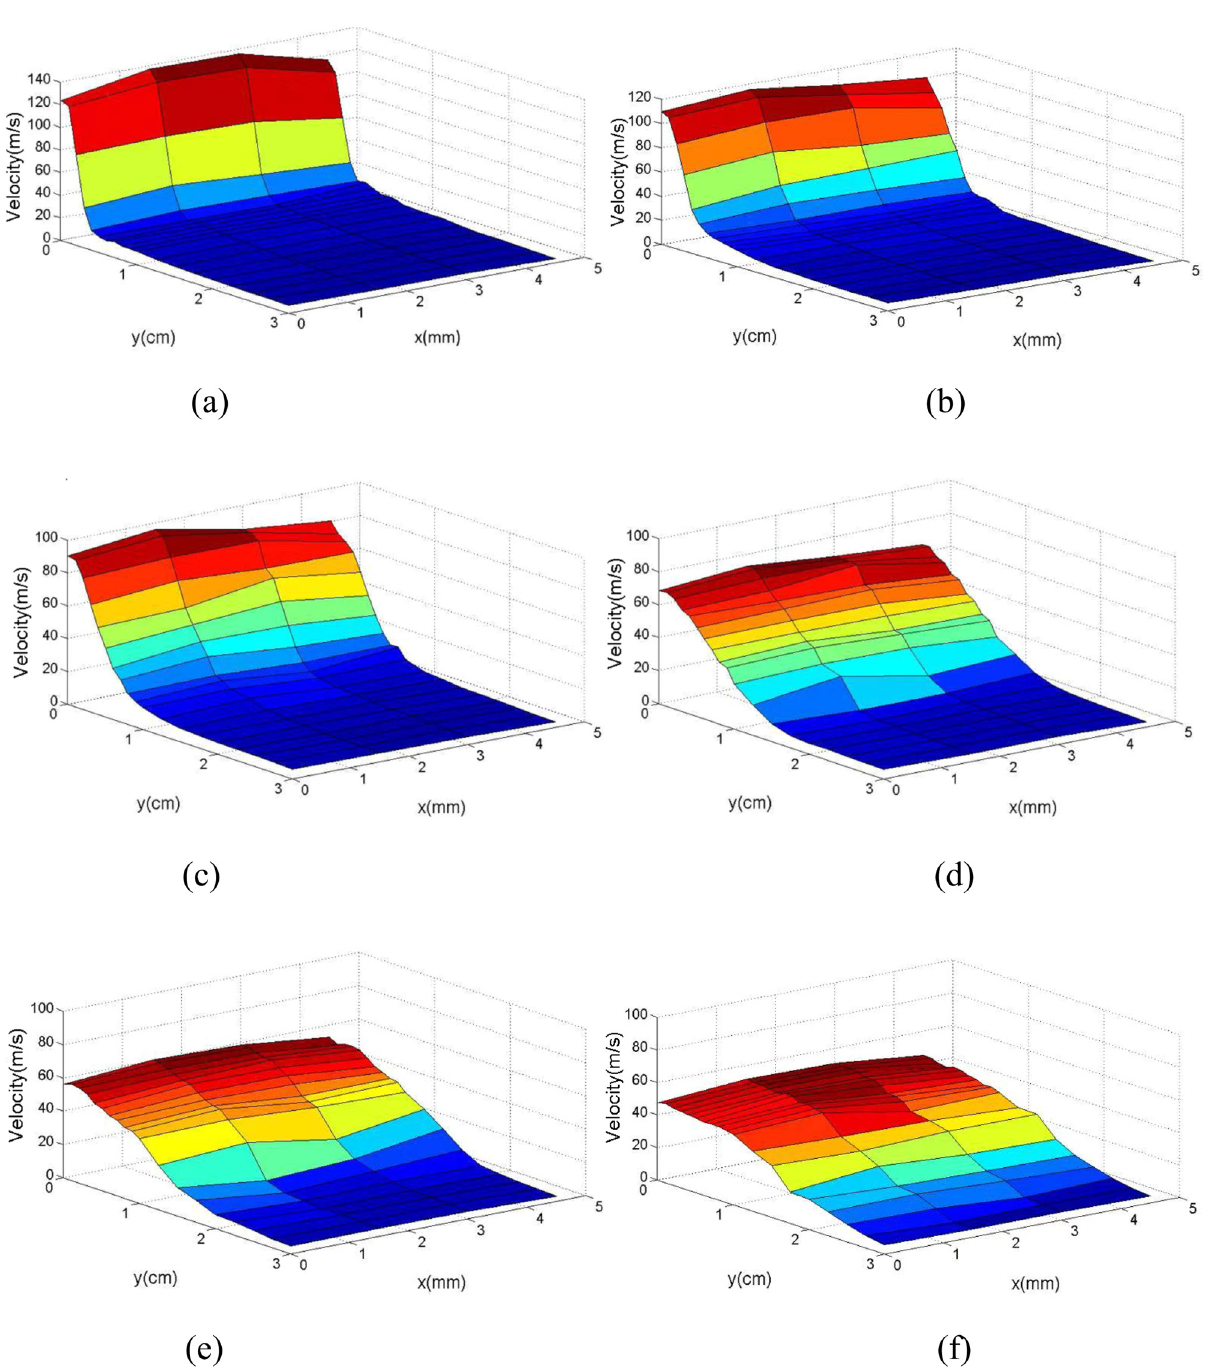
Figure 4: Velocity distribution on di ff erent z planes. ( a ) z = 9 mm, ( b ) z = 19 mm, ( c ) z = 29 mm, ( d ) z = 49 mm, ( e ) z = 69 mm, ( f ) z = 95